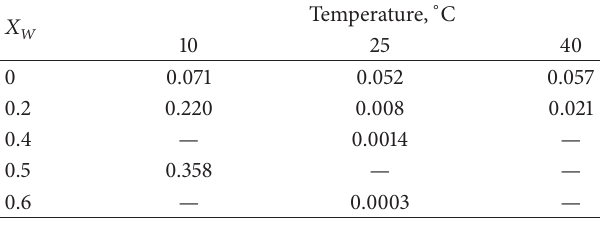
values from all experiments. SNT